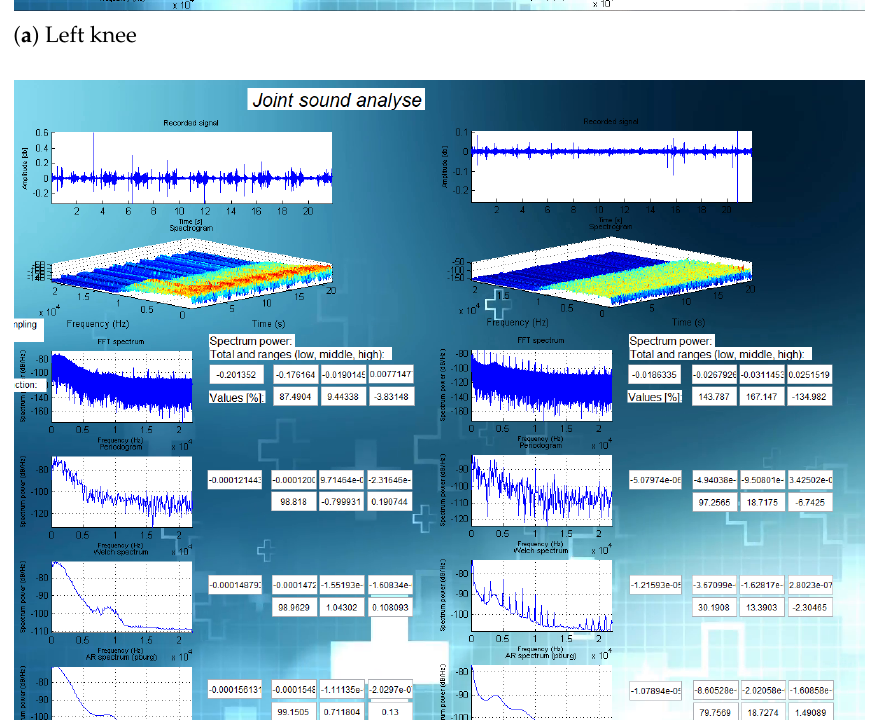
three different subjects measured by the left microphone on the left knee. Spectral powers were calculated in four different frequency bands: Total, low, medium, and